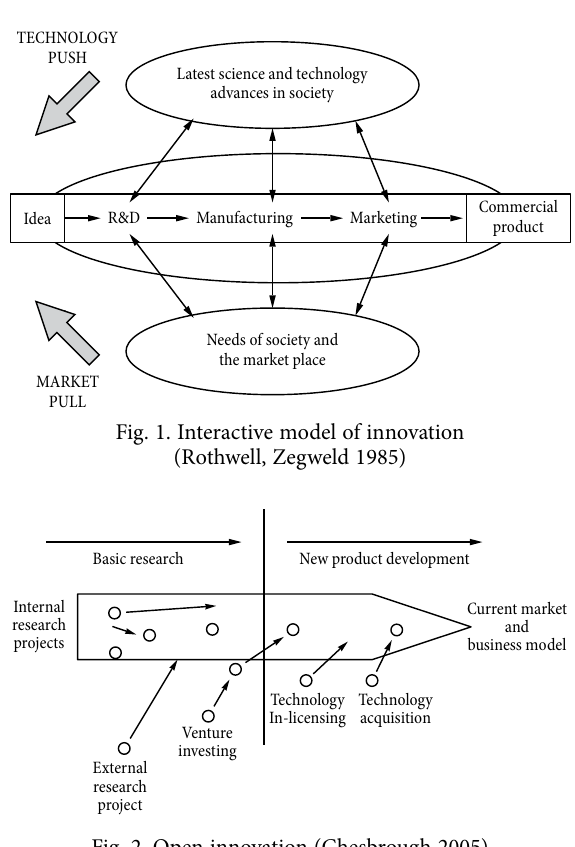
Fig. 2. Open innovation (Chesbrough